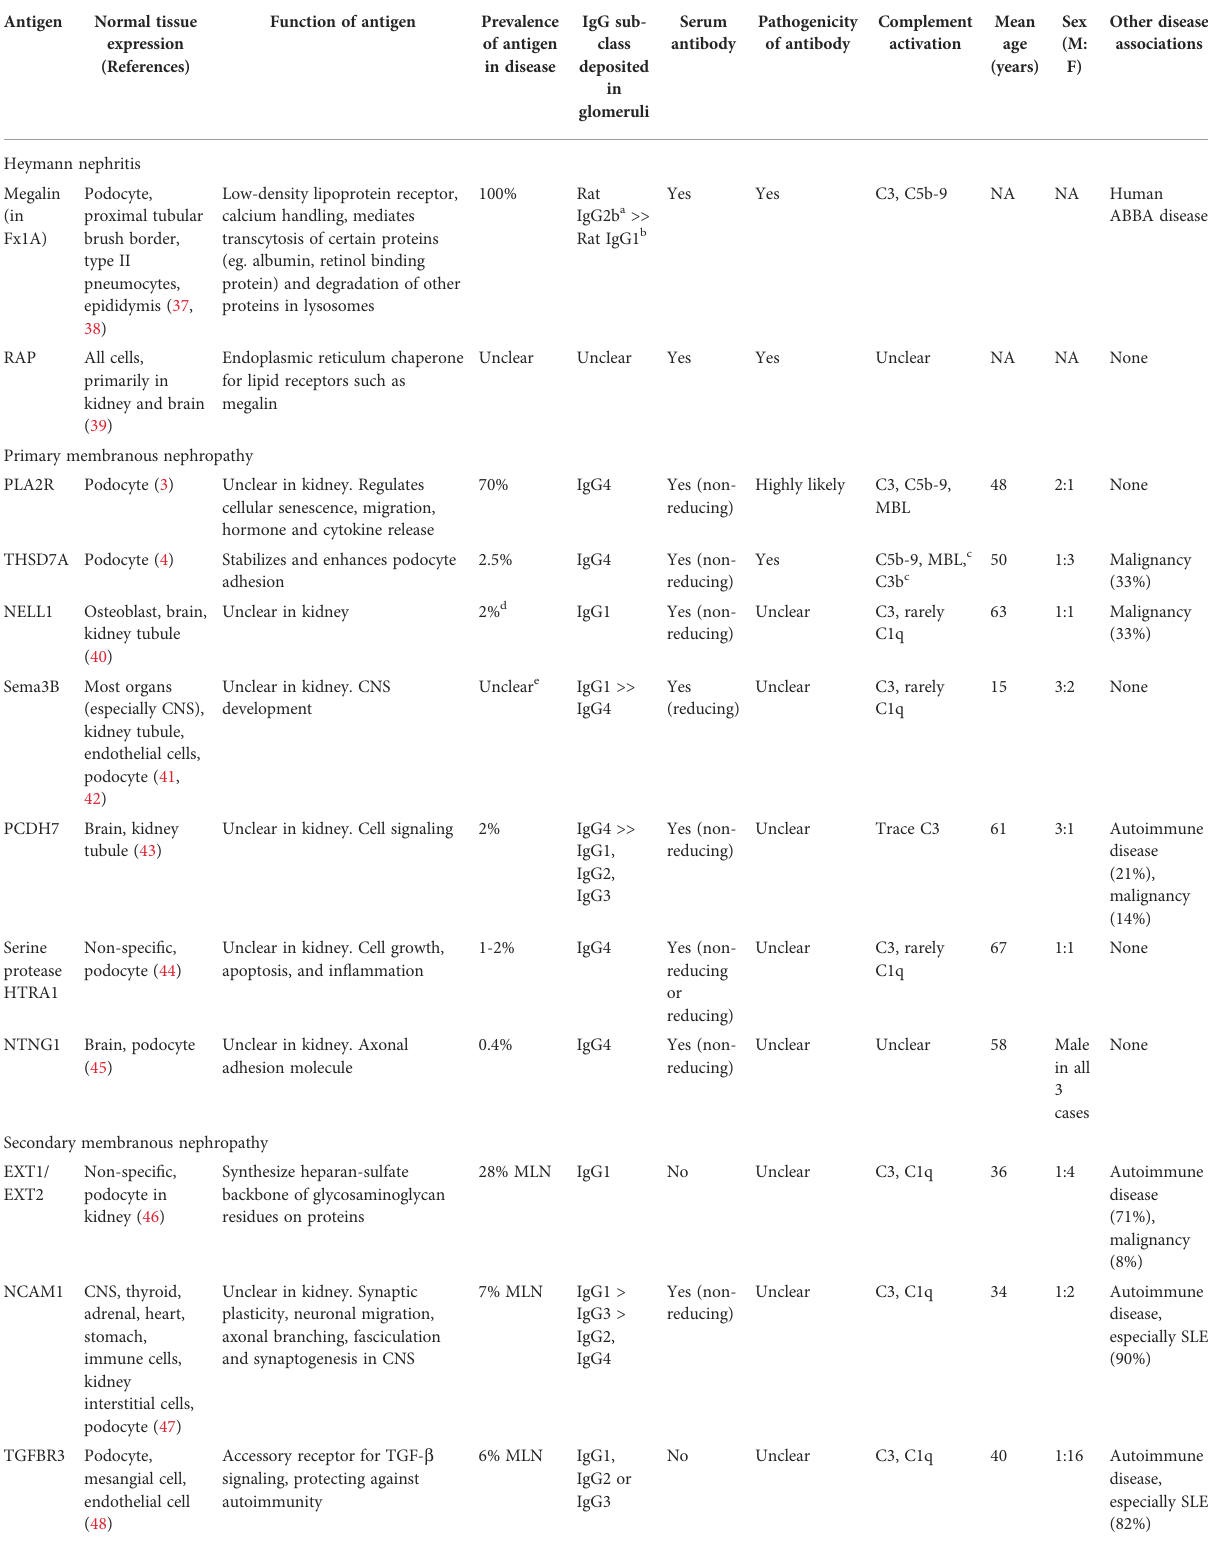
TABLE 1 Disease antigens implicated in Heymann nephritis and membranous nephropathy. Antigen Normal tissue